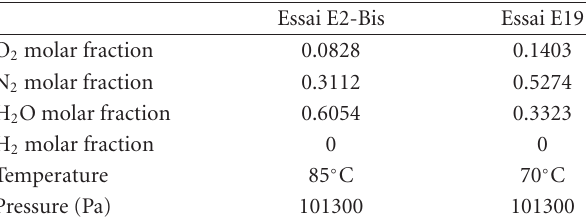
Table 1: Initial conditions—H 2 -PAR